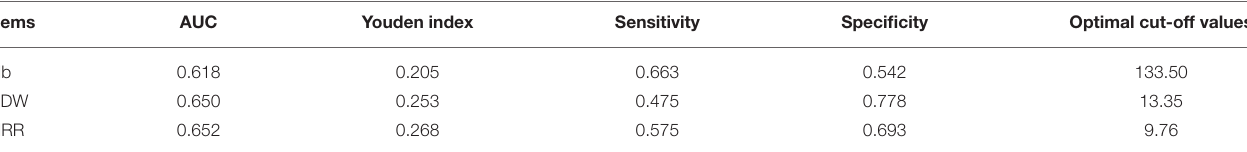
Items AUC Youden index Sensitivity Specificity Optimal cut-off